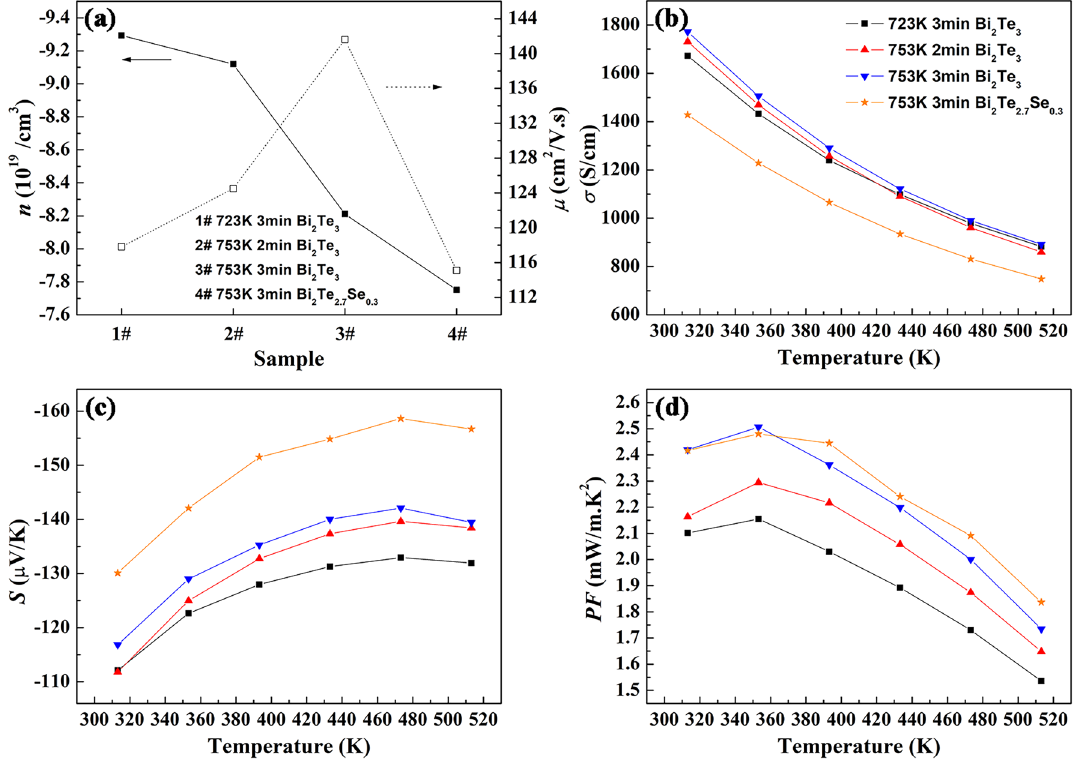
Figure 4. Electrical transport properties of the bulk Bi 2 Te 3−x Se x samples prepared by SPS on different conditions. ( a ) Carrier concentration n and mobility μ at 313 K, ( b – d ) Temperature dependence of electrical conductivity σ , Seebeck coefficient S and power factor PF